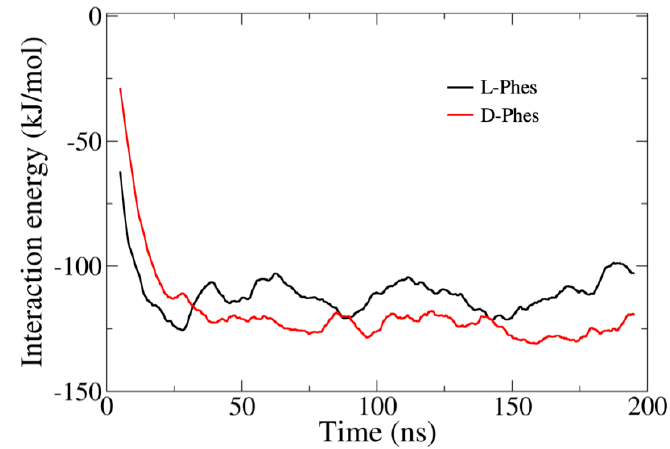
Figure 7. Lennard–Jones interaction components between the three phenylalanine residues and the hydrophobic tails of DMPC membrane. Three different runs of the peptides averaged, and the running average values are shown in this figure for every 1 ns.